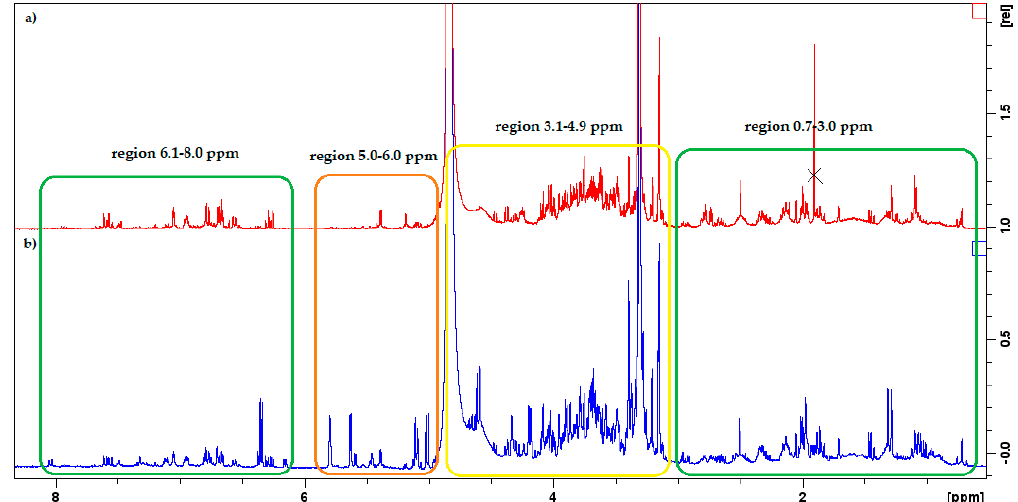
Figure 1. Overlaid 1 H-NMR spectra of both samples: ( a ) infusion of S. cypria ; ( b ) infusion of S. perfoliata subsp. perfoliata .